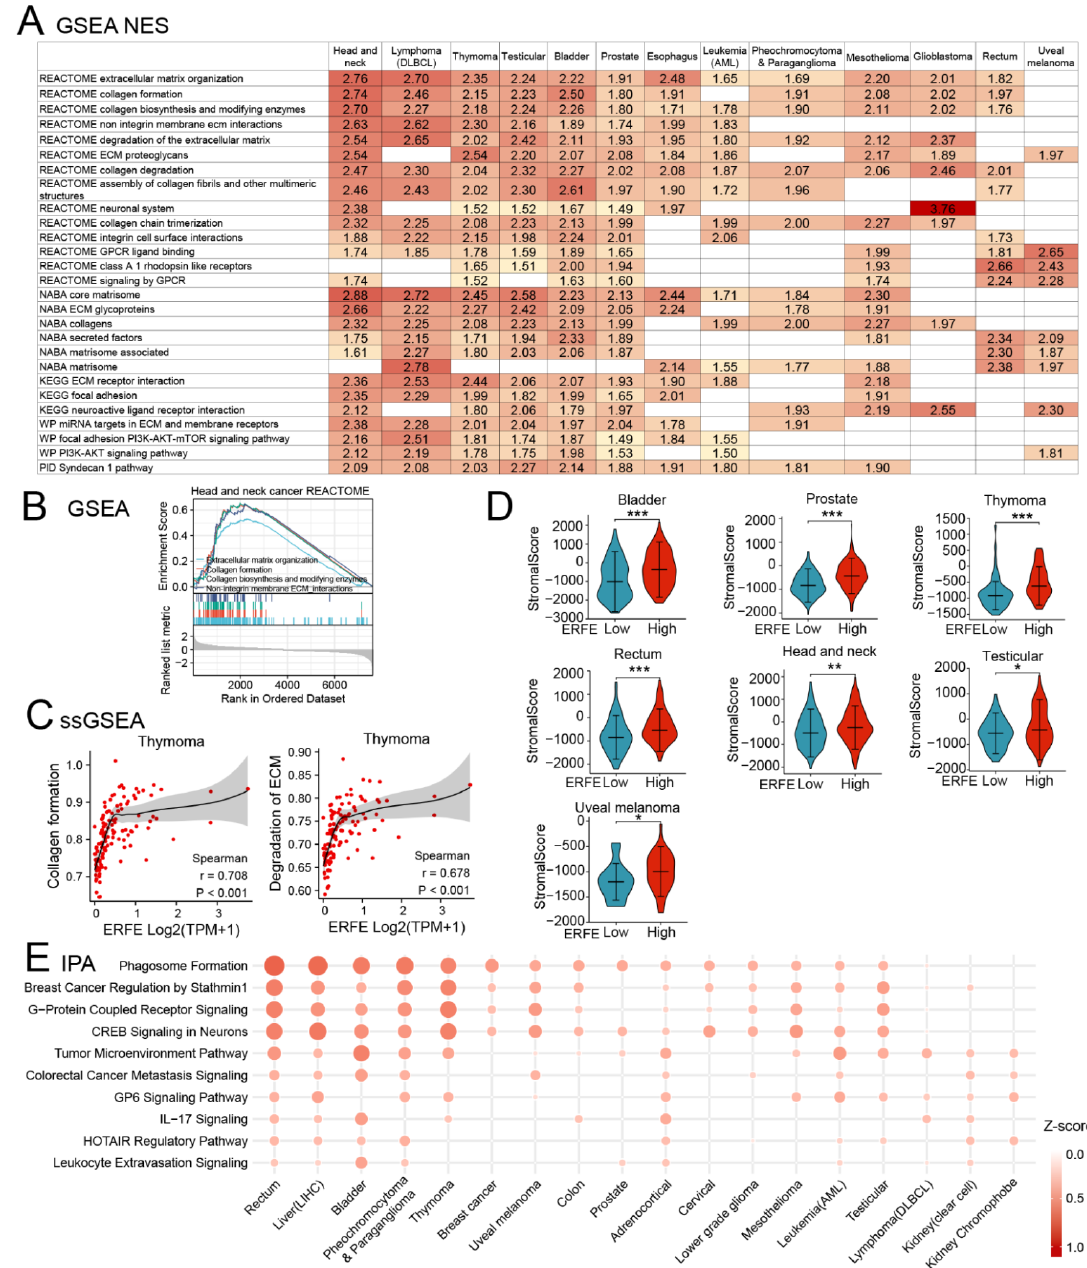
Figure 8. Upregulated pathways involved in higher ERFE expression. ( A ) Upregulated pathways upon ERFE high status were enriched by GSEA based on REACTOME, NABA, KEGG, WP, and PID databases and summarized with NES ≥ 1 and p < 0.05. ( B ) Representative GSEA result is shown for upregulated pathway involved in ECM remodeling. ( C ) Correlation between ERFE expression and pathway scores of “Collagen formation” and “Degradation of ECM” in thymoma is shown. Pathway score was calculated by ssGSEA. Spearman’s rank correlation test was carried out. ( D ) Stroma infiltration abundance was compared between ERFE high and ERFE low patients in pan-cancer. Stroma score was calculated by the ESTIMATE algorithm. The statistical difference of the two groups was compared by Wilcoxon rank sum test. Asterisks (*) stand for significance levels. * p < 0.05; ** p < 0.01; *** p < 0.001. ( E ) Upregulated pathways upon ERFE high status were enriched by IPA and summarized with Z-score ≥ 1 and p < 0.05. Abbreviation: NES, normalized enrichment